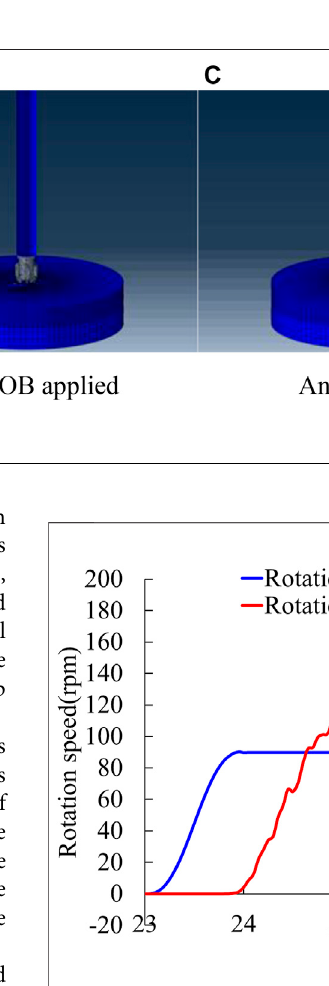
FIGURE 3 | Mesh division of formation and PDC bit.